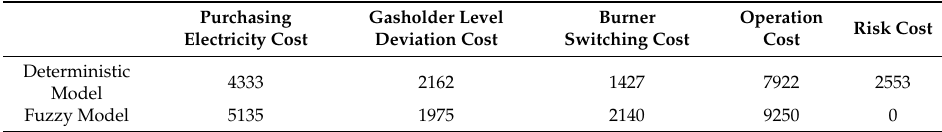
Table 6. Comparison of cost (US$) based on two models.